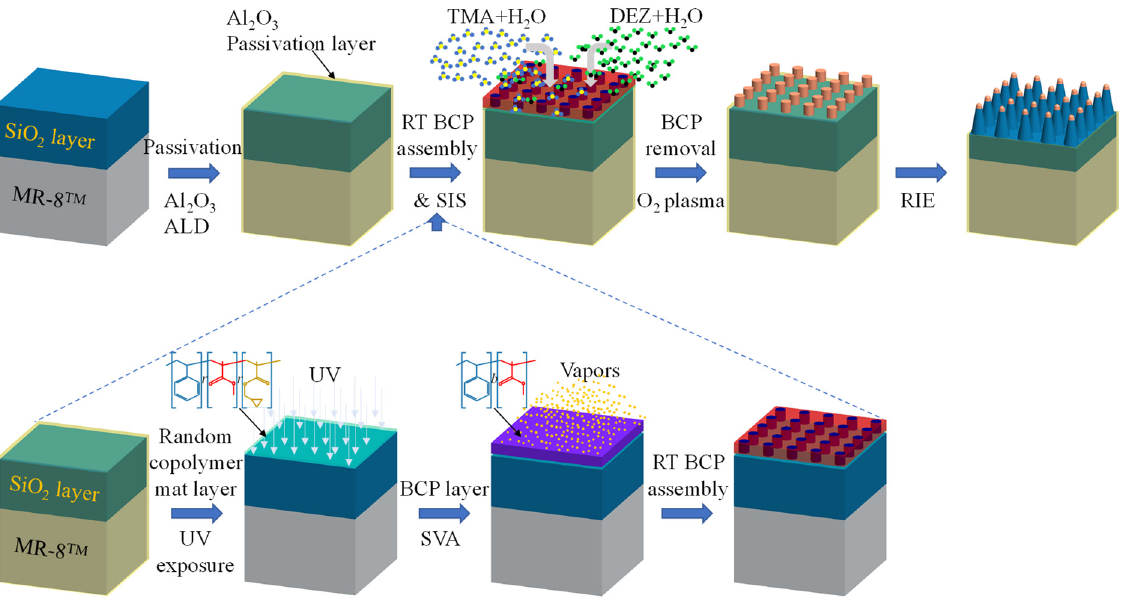
Figure 1. Schematic illustration of the developed processes. The process starts with SiO 2 /MR-8 TM polymeric substrate passivation using Al 2 O 3 ALD, followed by room-temperature BCP assembly—random copolymer mat layer crosslinking using UV exposure and SVA of cylinder-forming PS- b -PMMA to promote self-assembly. Growth of AlO x and ZnO within the BCP layer is performed using TMA/H 2 O and DEZ/H 2 O SIS processes, followed by polymer template removal. Finally, the pattern is transferred to the SiO 2 layer with RIE.